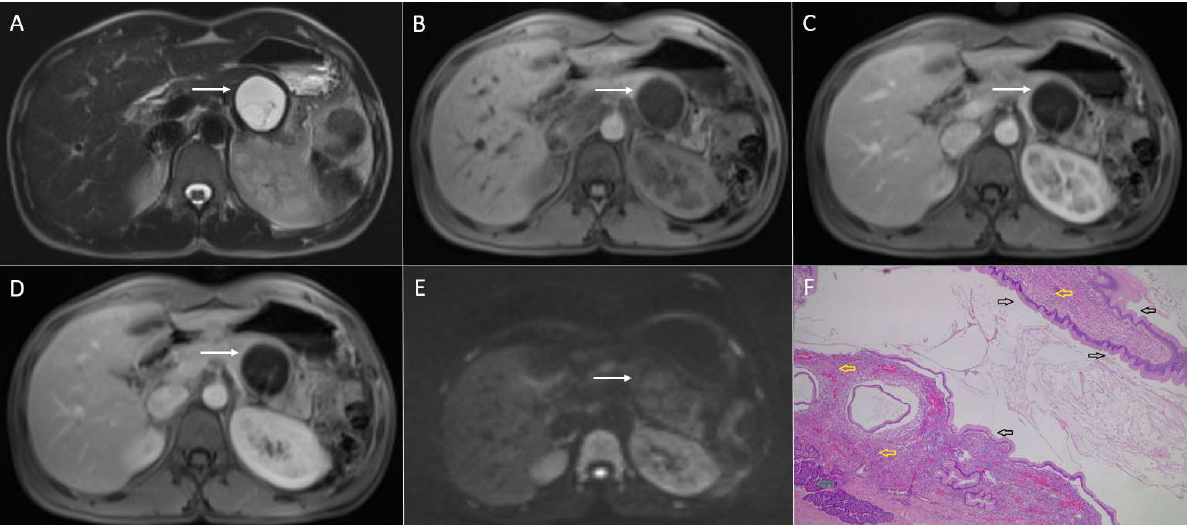
Figure 12. Mucinous cystadenoma in 39-year-old woman. On T2-weighted image ( A ) of a well-demarcated cystic lesion ( arrow ) with discrete internal septations is seen in the pancreatic tail. On T1-weighted fat-suppressed image ( B ), the lesion is hypointense ( arrow ) without enhancement in arterial phase except in septations ( C ), which is better depicted in portal-venous ( D ) phase. The lesion ( arrow ) does not show diffusion restriction ( E ). Hematoxylin and eosin (H&E) staining ( F ) showed mucinous cystadenoma with mucinous epithelium lining cyst ( black arrows ). Ovarian stroma is also depicted ( yellow arrows ). Normal pancreatic parenchyma is seen next to the tumor ( green arrow ); original magnification ×400.